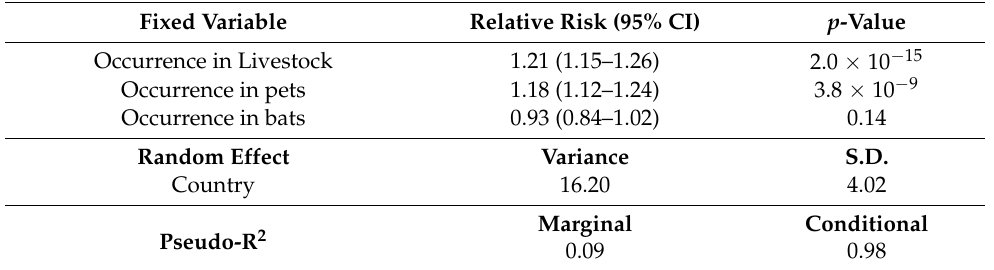
R 2 (variance explained by the whole model) are